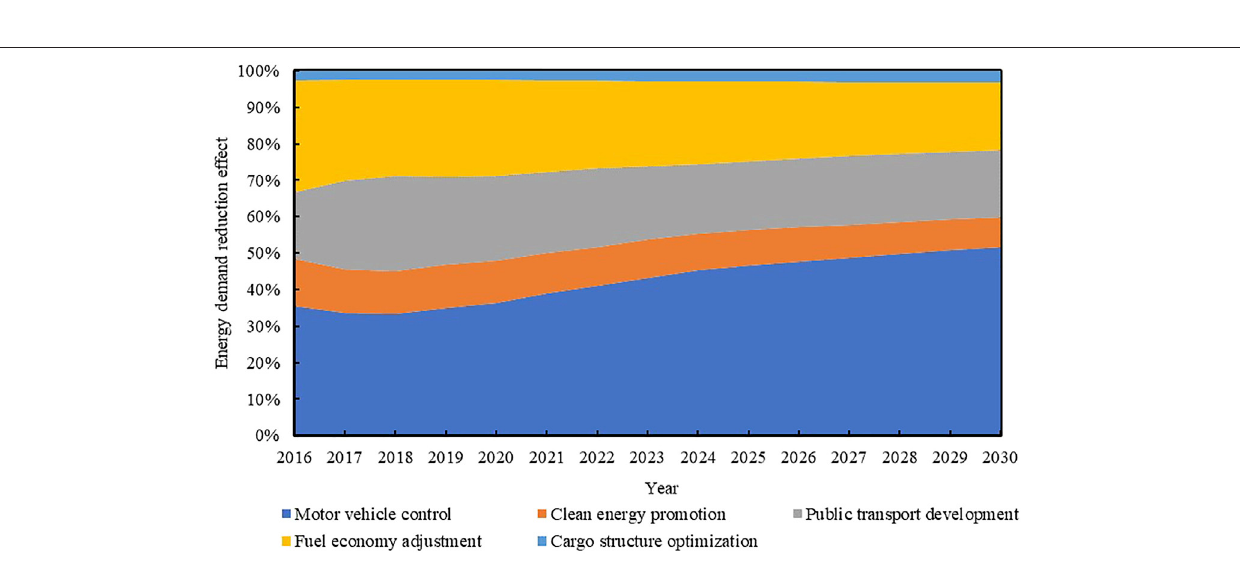
Frontiers in Environmental Science |